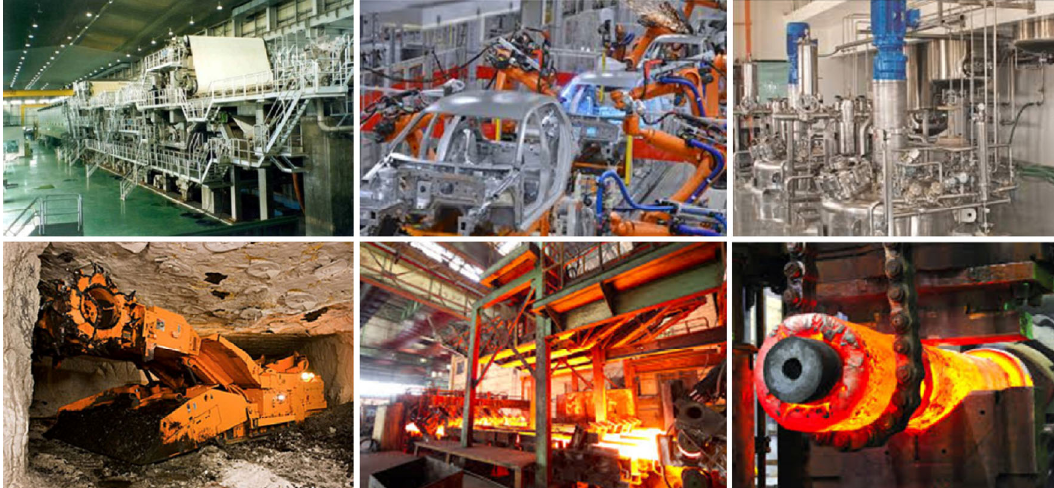
Fig. 5 Production machines in paper, car, food, mining and steel